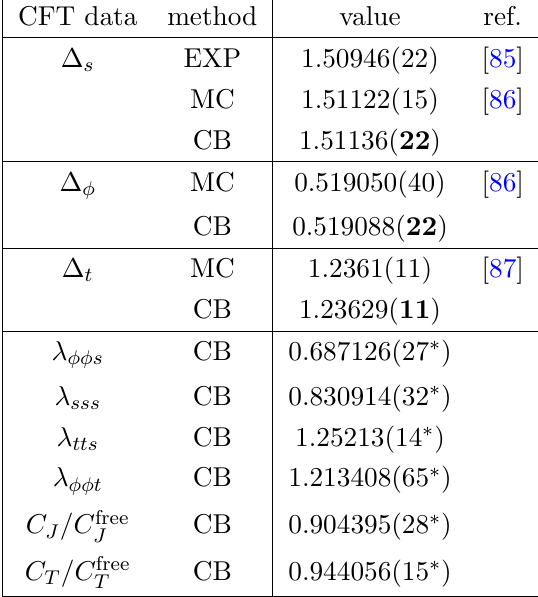
Table 1 . Comparison of conformal bootstrap (CB) results with previous determinations from Monte Carlo (MC) or experiment (EXP). We denote the leading charge 0, 1, and 2 scalars by s; (cid:30); t , respectively. Bold uncertainties correspond to rigorous intervals from bootstrap bounds. Uncertainties marked with a (cid:3) indicate that the value is estimated non-rigorously by sampling points, see sections 4.2 and